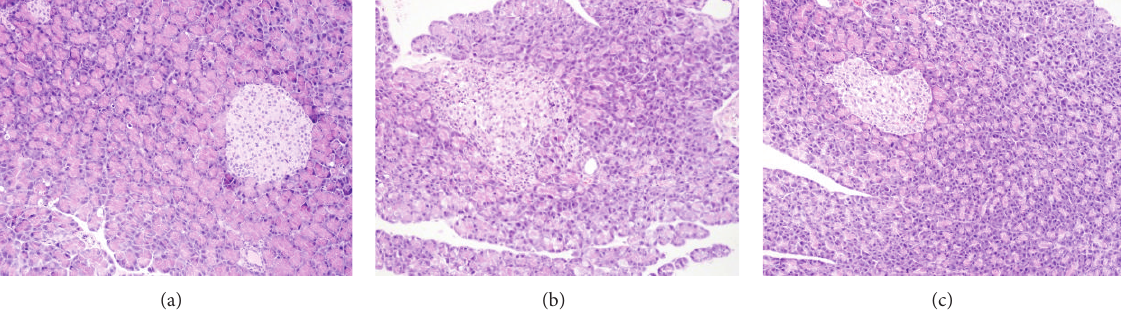
Figure 1: Comparison of pancreatic morphology of rats in three groups (HE, × 200). (a) Normal pregnancy group: normal pancreas. (b) Gestational diabetes mellitus as the control group: mild atrophy of islet, B cells moderate swelling, and interstitial inflammatory cells infiltration. (c) Zuogui Wan gestational diabetes mellitus group: pancreatic B cells swelled moderately and vacuolar degeneration occurred. The number of pancreatic B cells reduced